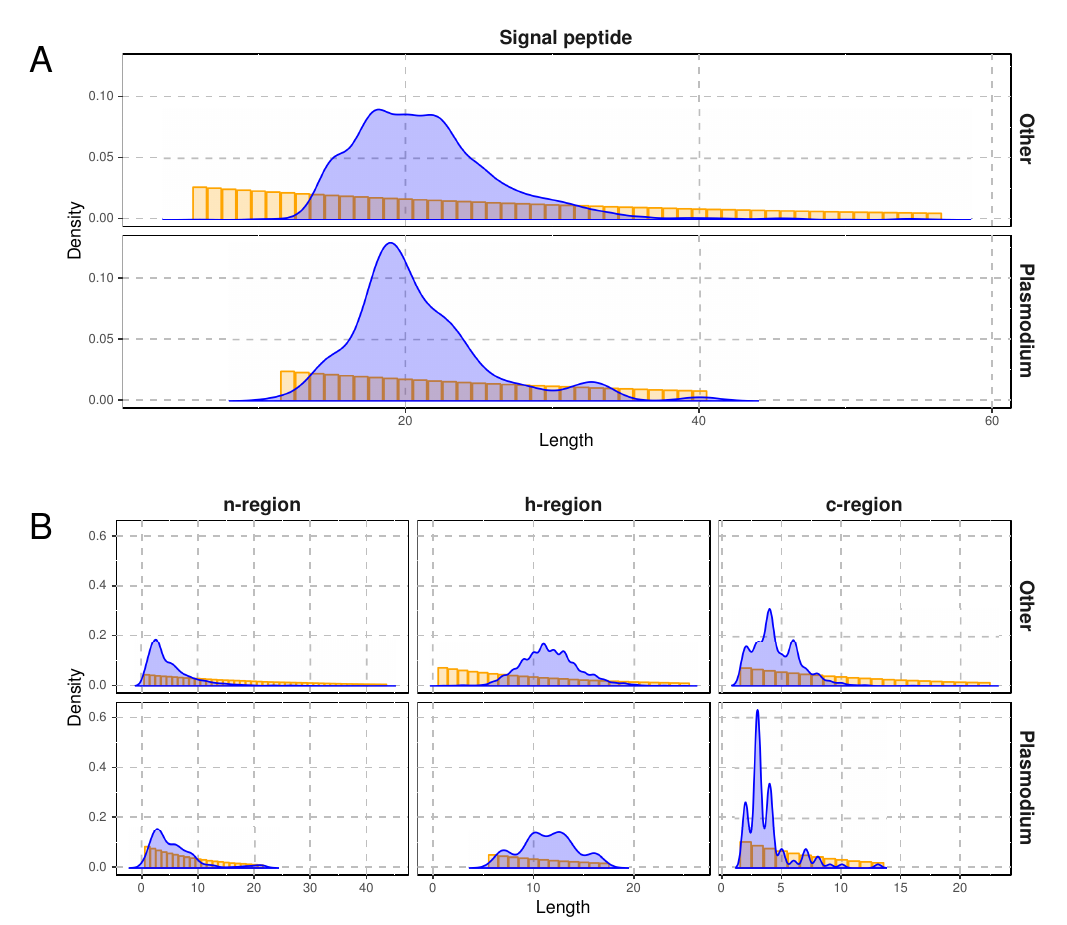
Figure 2. Distribution of lengths for SPs ( A ) and their regions ( B ) expressed in the number of amino acid residues for sequences with the representatives of the Plasmodiidae family (Plasmodium) and without them (Other). Yellow bars represent a fitted geometric